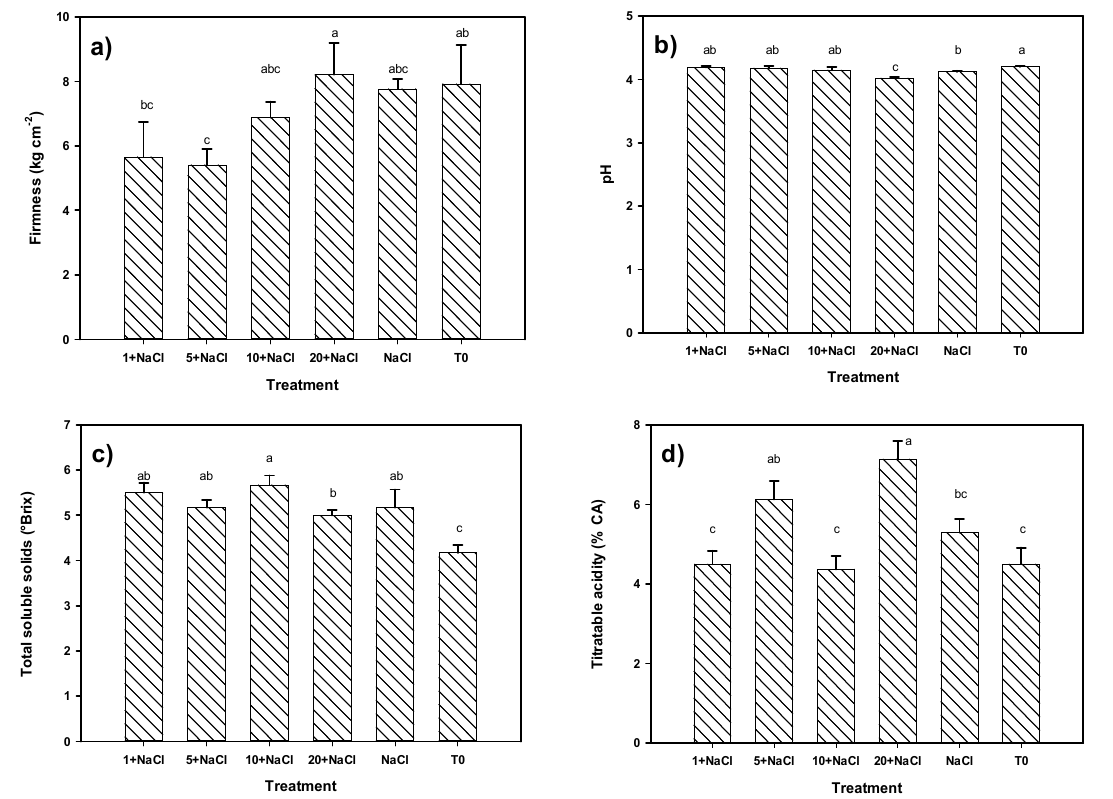
Figure 7. Tomato fruit quality parameters ( a ) Firmness, ( b ) pH, ( c ) Total soluble solids, ( d ) Titratable acidity of plants under NaCl stress and an application of Se NPs. T0: Control. NaCl: NaCl-only treatment. The terms 1, 5, 10, and 20 + NaCl represent the amount of Se NPs applied (mg L − 1 ) plus 50 mM of NaCl. Di ff erent letters per column indicate significant di ff erences according to Fisher’s least significant di ff erence test ( p < 0.05).